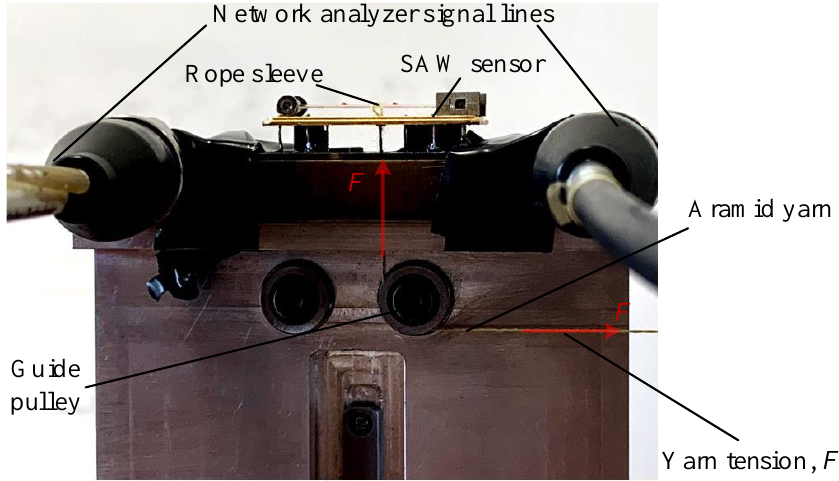
Figure 11. The measurement system of simply supported beam SAW yarn tension sensor.